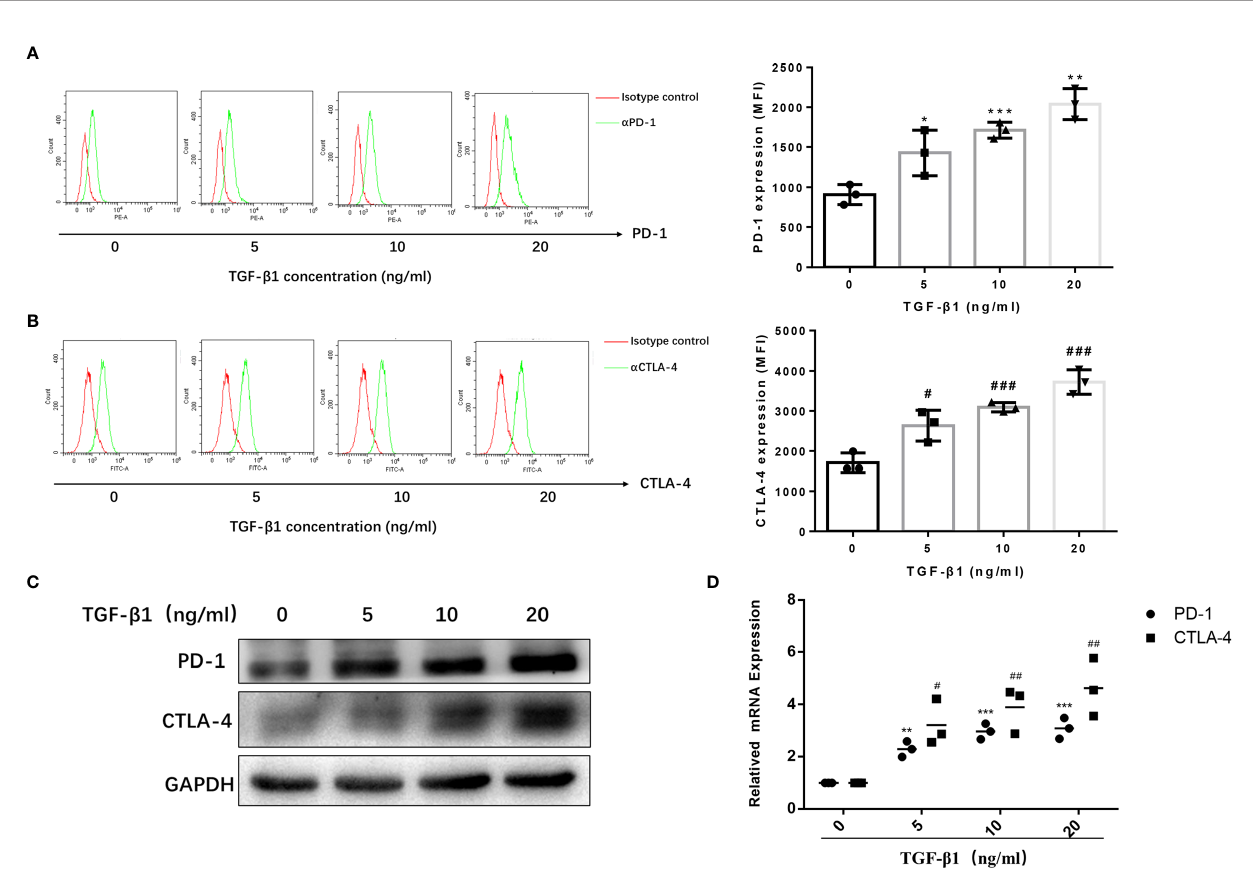
FIGURE 1 | TGF- b 1 enhances the expression of PD-1 and CTLA-4 on activated T cells. T cells were activated and treated with TGF- b 1 (0, 5,10, 20 ng/mL) for 48 h. (A) The expression of PD-1 on T cells was analyzed by fl ow cytometry. (B) The expression of CTLA-4 on T cells was analyzed by fl ow cytometry. (C) The protein expression levels of PD-1 and CTLA-4 in T cells were analyzed by western blotting. (D) The mRNA levels of PD-1 and CTLA-4 in T cells were analyzed by qPCR. n = 3, *P <0.05, **P <0.01, ***P < 0.001 vs. control group; # P < 0.05, ## P < 0.01, ### P < 0.001 vs. control